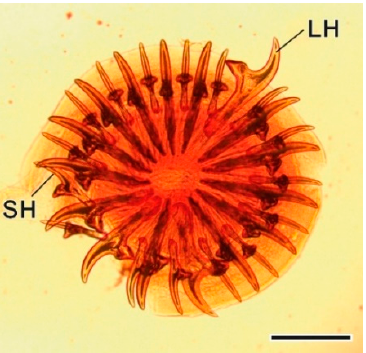
Figure 3. Rostellar hooks of Hydatigera taeniaeformis larvae. LH, large hook; SH, small hook. Scale bar = 300 µm.